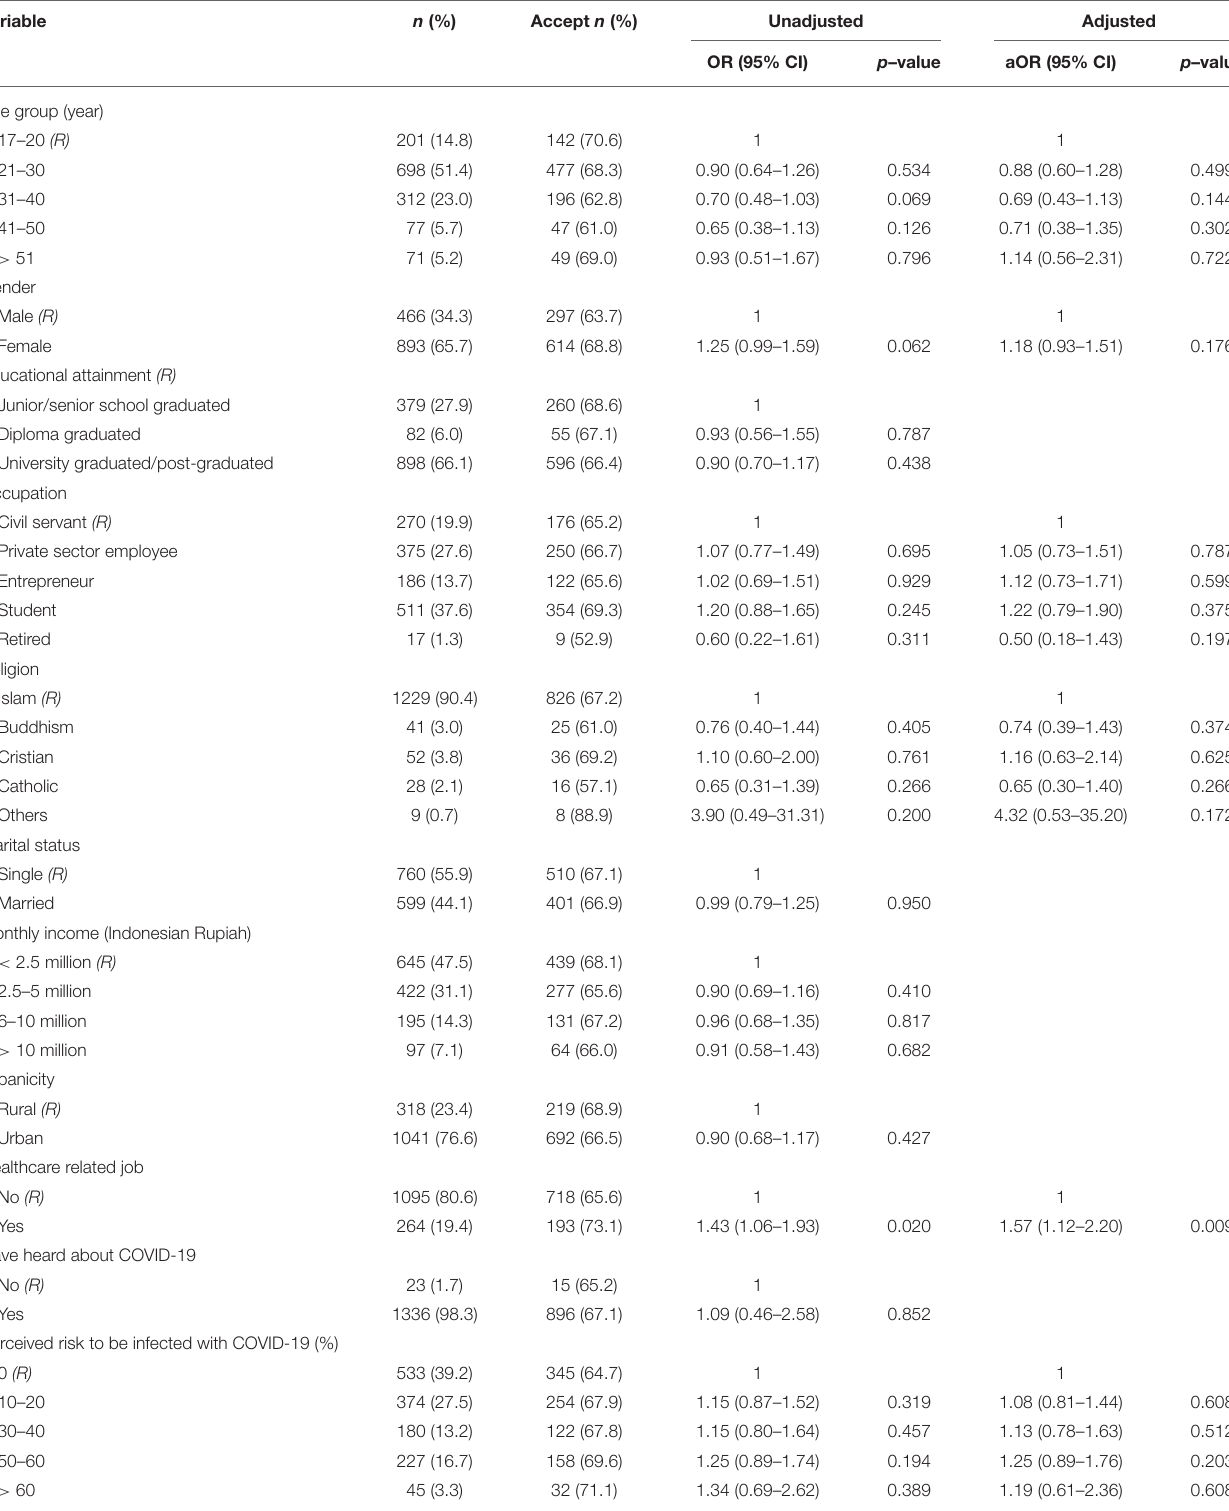
TABLE 2 | Unadjusted and adjusted logistic regression analyses showing factors associated with acceptance of a COVID-19 vaccine in Indonesia, 50% effectiveness ( n = 1,359).